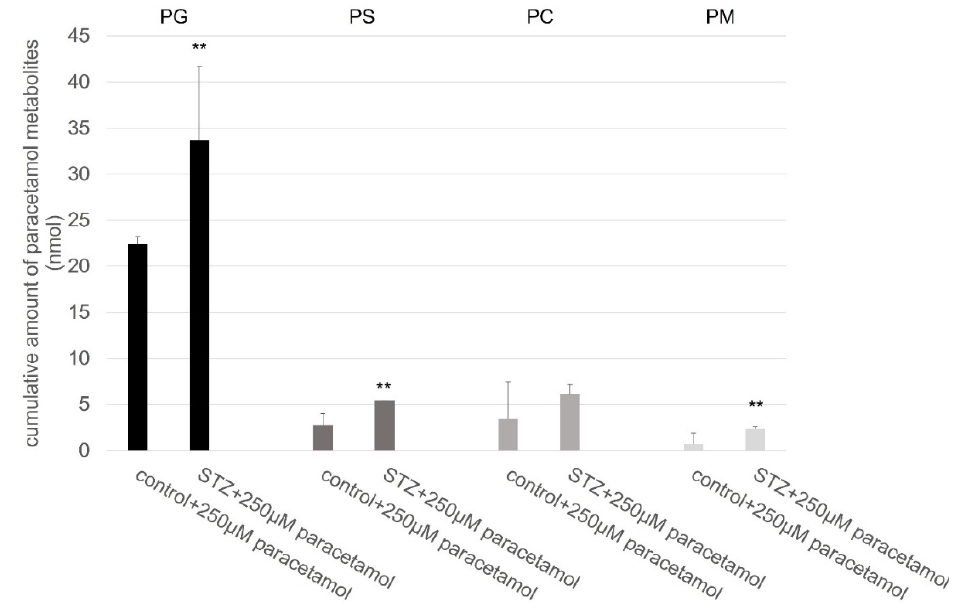
Figure 3. Changes in the excreted amount of paracetamol β‐ D ‐ glucuronide (PG), paracetamol sulphate (PS), paracetamol cysteine (PC), and paracetamol mercapturate (PM) into the lumen of the small intestine of rat during perfusion of the jejunal loop with isotonic medium containing 250 μ M paracetamol. Each value represents the mean of 5 independent experiments ± standard error. **, p < 0.01 versus control and STZ pretreated groups.